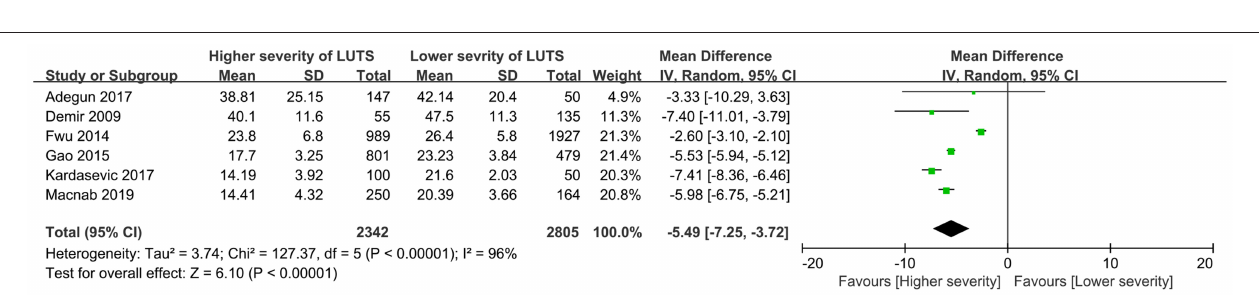
lower severity (WMD = − 1.69, 95%CI: − 2.73 to − 0.65, P = 0.001, Figure 4C